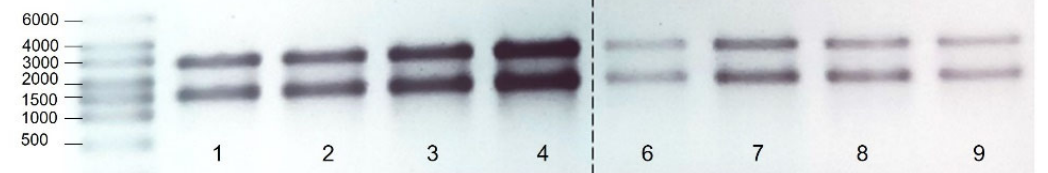
Figure 2. Image of gel electrophoresis of RNA from S. aureus from culture after 2 h and 5 h of incubation (condition I) from at least four independent experiments. The 16 S and 23 S (bacterial) rRNA bands are visible. Numbers refer to Table 1’s samples. RNA ladder in bp. The amount detected on gel does not correspond with the amount measured via Nanodrop. The sample 5 has not enough material and it is not shown. Table 2 . List of RNA samples of intracellular S. aureus (gel shown in Figure 3) 90 min, 24 h, and 48 h postinfection (condition II) including the amount recovered and the ratios measured via Nanodrop. * Not enough material for gel electrophoresis was available. Sample No.